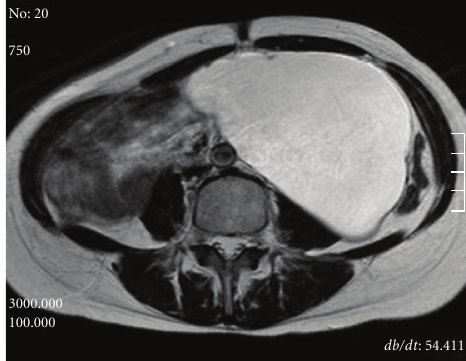
Figure 4: Structure of the SAND balloon db/dt